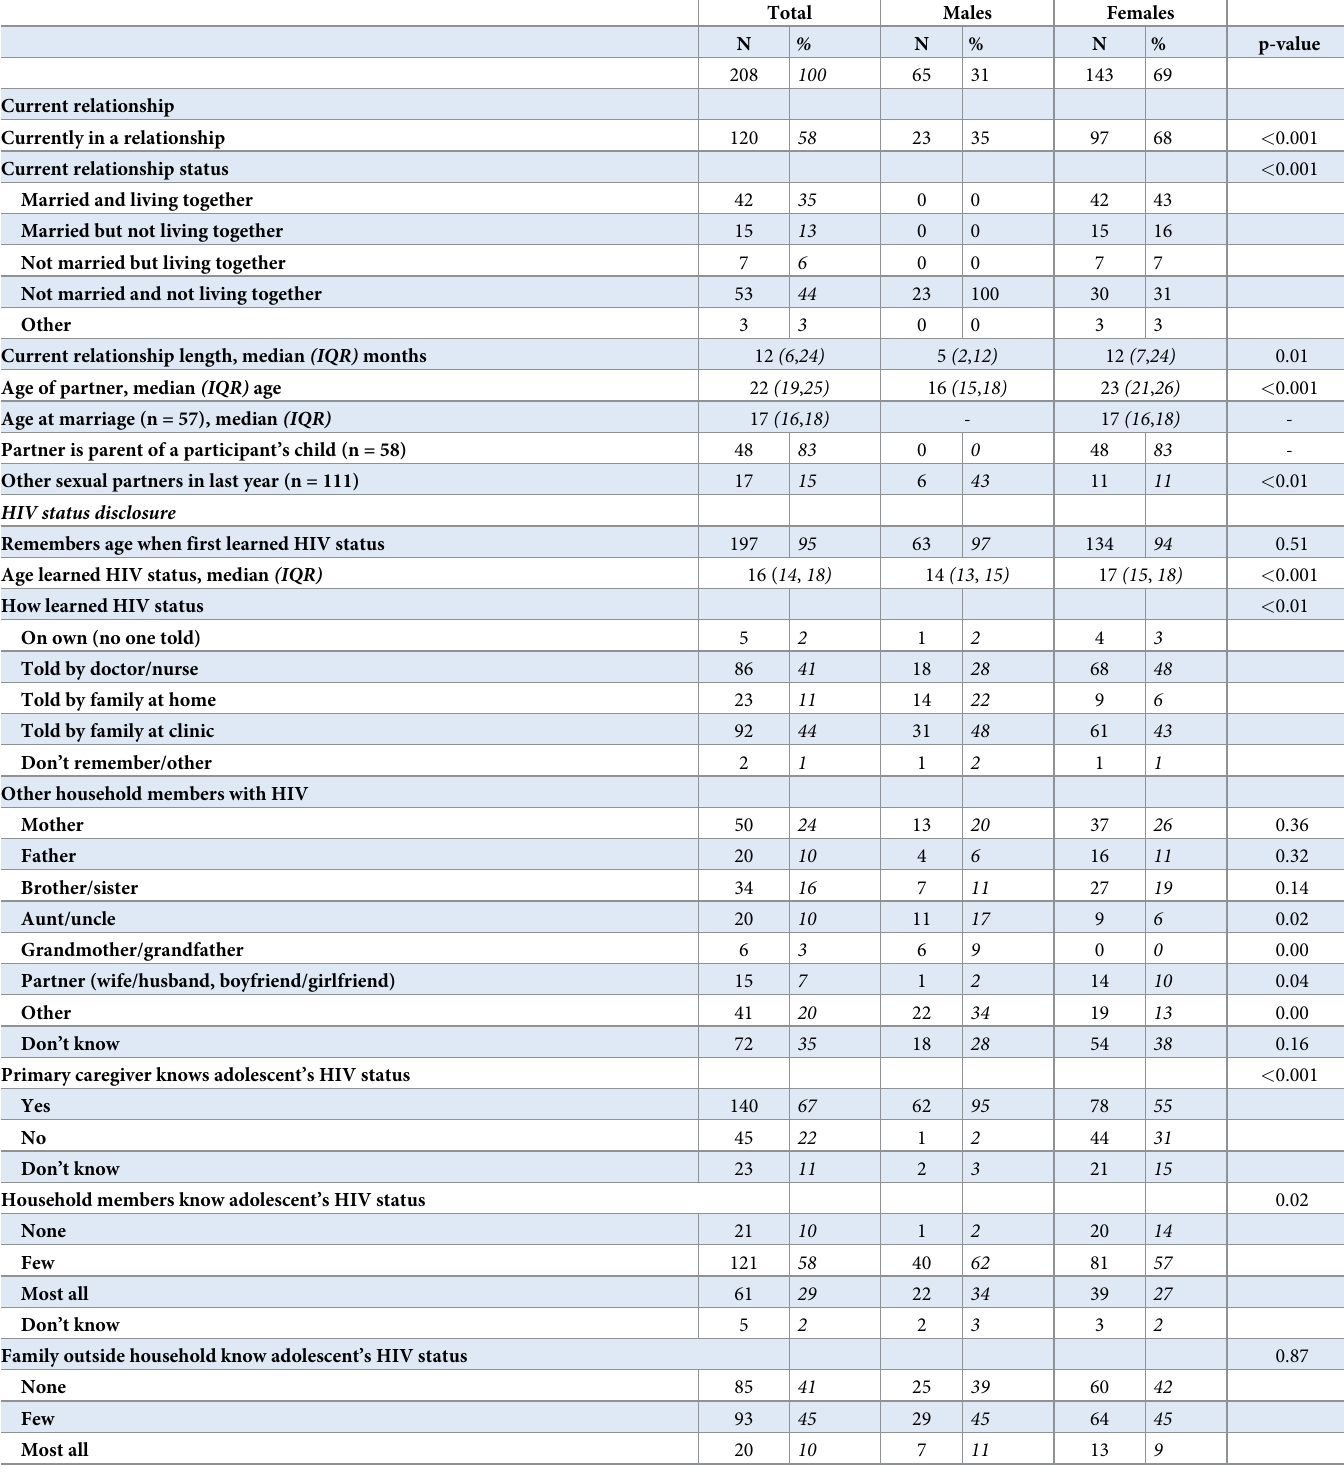
Table 3. Relationship status, HIV stigma/disclosure and community engagement among ALHIV 15–19 years of age enrolled in HIV care in Nampula, Mozambique, 2019 (N =